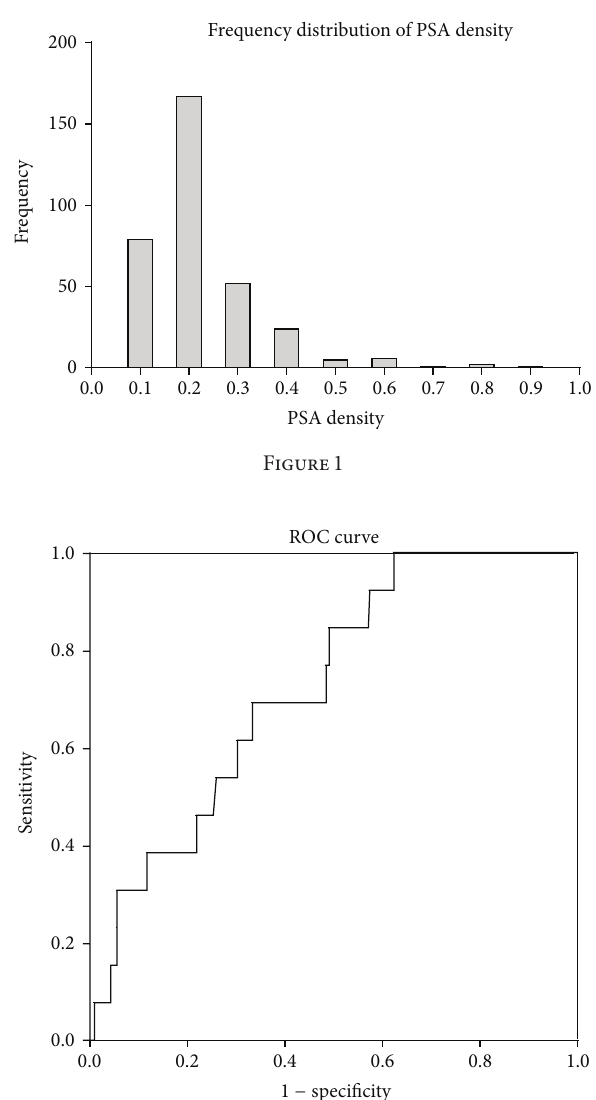
Figure 2: ROC curve for the prediction of biochemical recurrence (PSA > 0.2) by PSA density. 𝑅 2 = 0.73